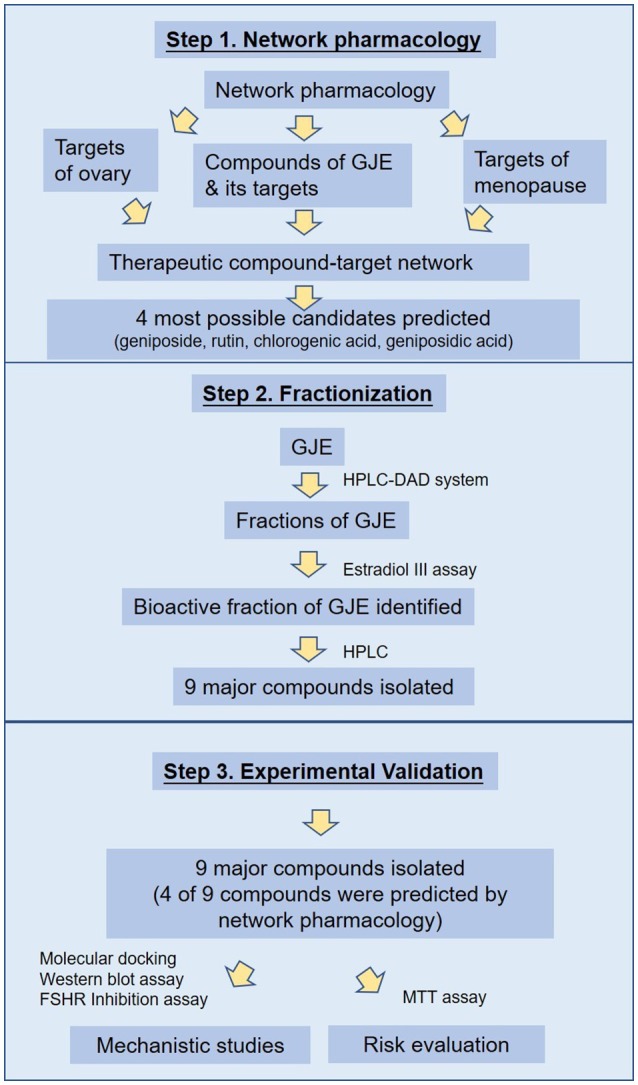
Process overview.